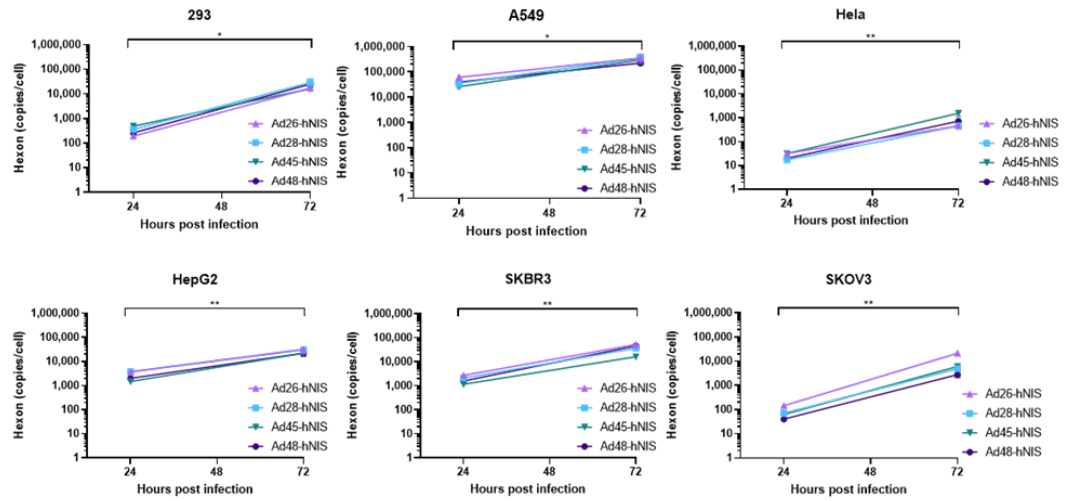
Figure 7. Replication kinetics of the recombinant species D Ad-hNIS viruses in the cancer cell lines. The gDNA replication kinetics of the four species D Ad-hNIS viruses were examined in each cancer cell line using qPCR for the Ad hexon gene. Cells were infected with 500vp / cell of the indicated Ad-hNIS and DNA was isolated at 24 and 72 h post infection. Hexon copies are displayed per cell as determined by the β -actin gene. Real-time qPCR was performed in triplicate and presented as mean ± standard deviation (SD) (* p < 0.05, ** p < 0.01; two-tailed t -test).